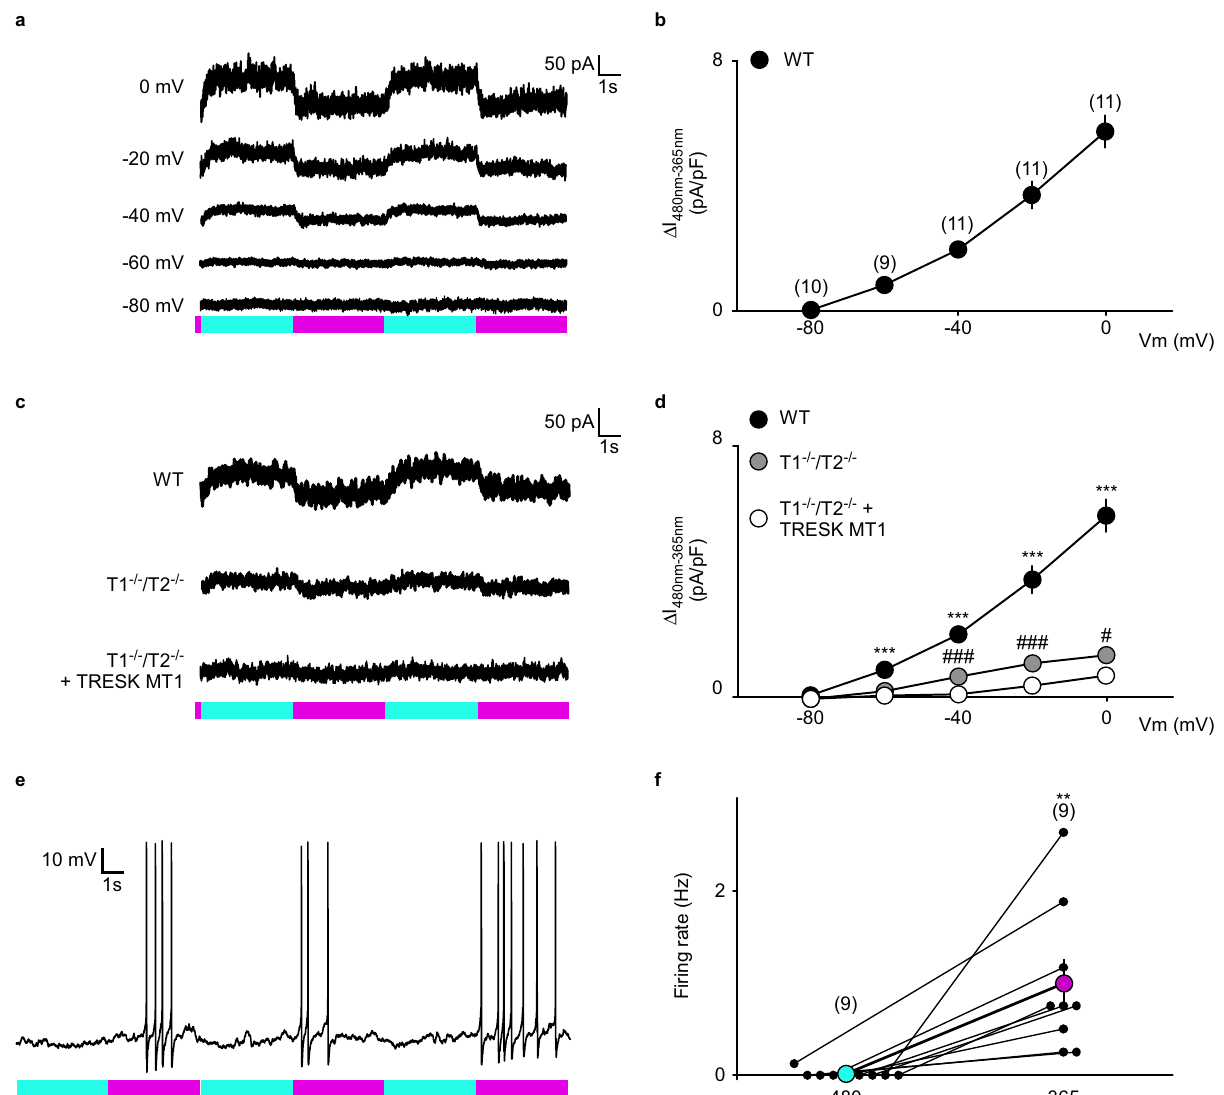
Fig. 2 | LAKIspeci fi callyphotoblocksTREK1, TREK2and TRESKin native small sensory neurons. a Whole-cell current recordings elicited at different holding potentials from wild-type (WT) TG neurons in the presence of LAKI (10 µ M) upon alternating illumination at 480nm (blue) and 365nm (magenta). b IV relationship ofthephotocurrentdensityinducedbyalternatingillumination(I 480nm – I 365nm )in WTTGneuronsinthepresenceofLAKI(10 µ M).nwasobtainedfromsixmicefrom two independent experiments. c Whole-cell current recordings elicited at 0mV from WT TG neurons, Trek1 − / − /Trek2 − / − TG neurons and Trek1 − / − /Trek2 − / − TGneurons overexpressing TRESK-MT1 in the presence of LAKI (10 µ M) upon alternating illu- mination at 480nm (blue) and 365nm (magenta). d IV relationship of the photo- currentdensity(I